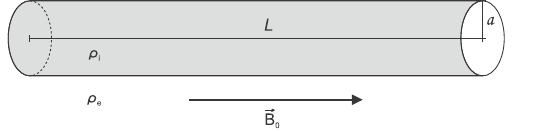
Fig. 43 Sketch of an infinitely long thread immersed in the solar corona. The prominence thread and the coronal density ( ρ i and ρ e ) are denoted as ρ p and ρ c in the text. Image reproduced with permission from Lin et al. (2009), copyright by